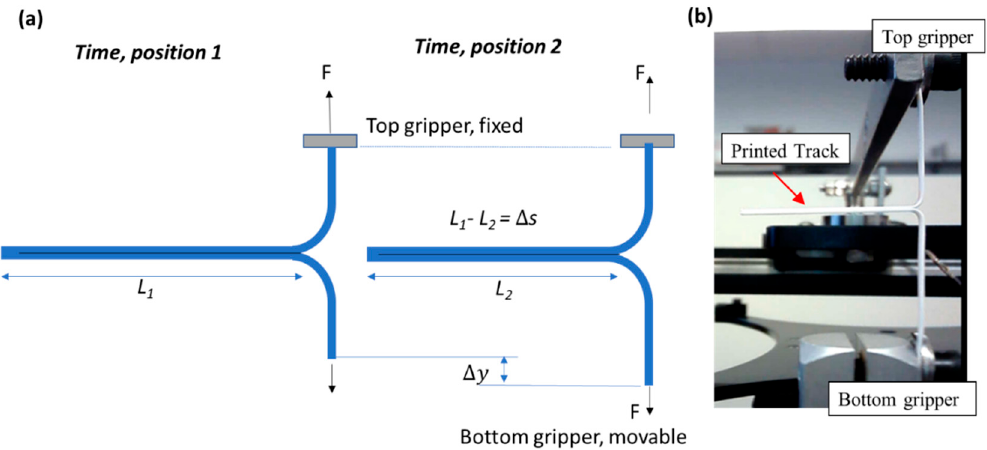
Figure 2. Trouser peel test of two-layer single track specimens for interfacial adhesion strength testing. ( a ) concept sketch, ( b ) actual peel test of printed double track specimens.